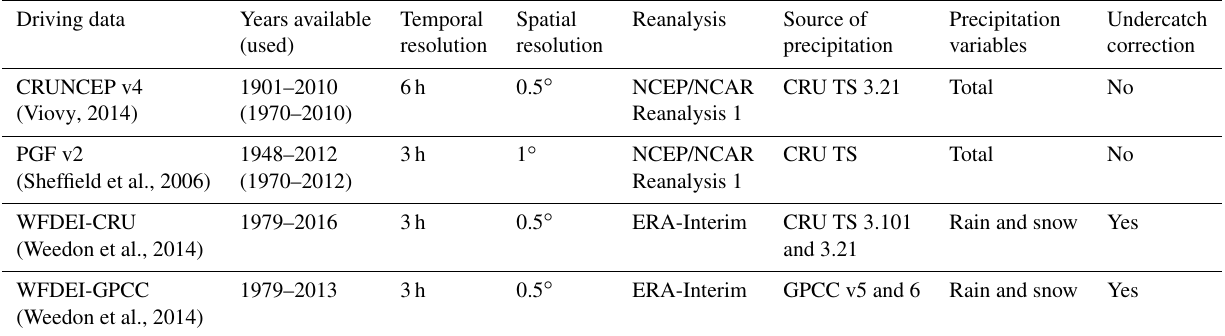
Table 1. Summary of meteorological driving data. Driving